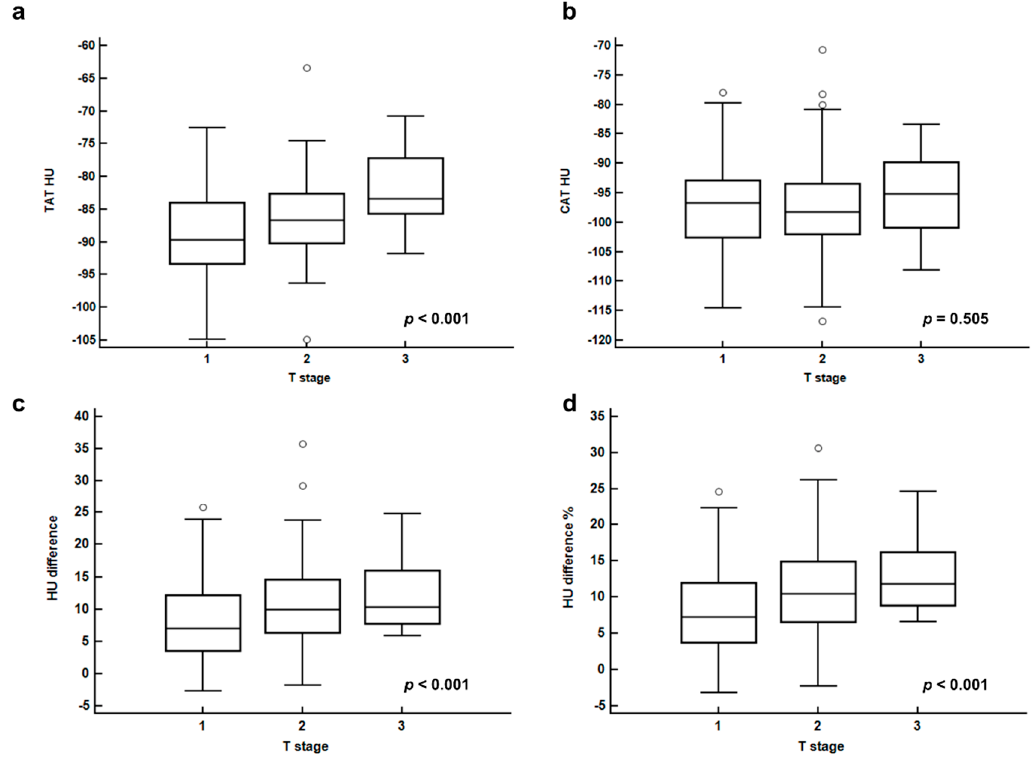
Figure 1. CT-attenuation of tumor-adjacent breast adipose tissue (TAT HU) ( a ), CT-attenuation of contralateral breast adipose tissue (CAT HU) ( b ), difference of CT-attenuation (HU difference) ( c ), and percent difference of CT-attenuation (HU difference %) ( d ), according to T stage.